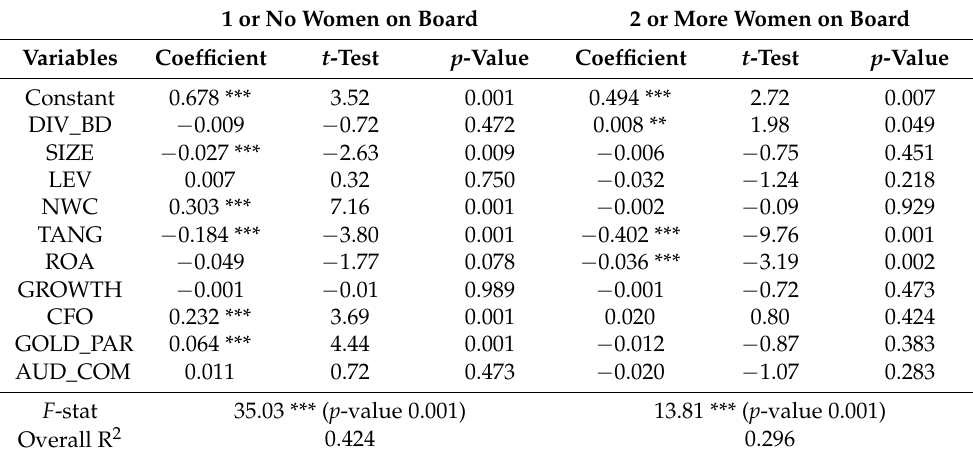
Table 5. Fixed-effect regression results of the main model under critical mass